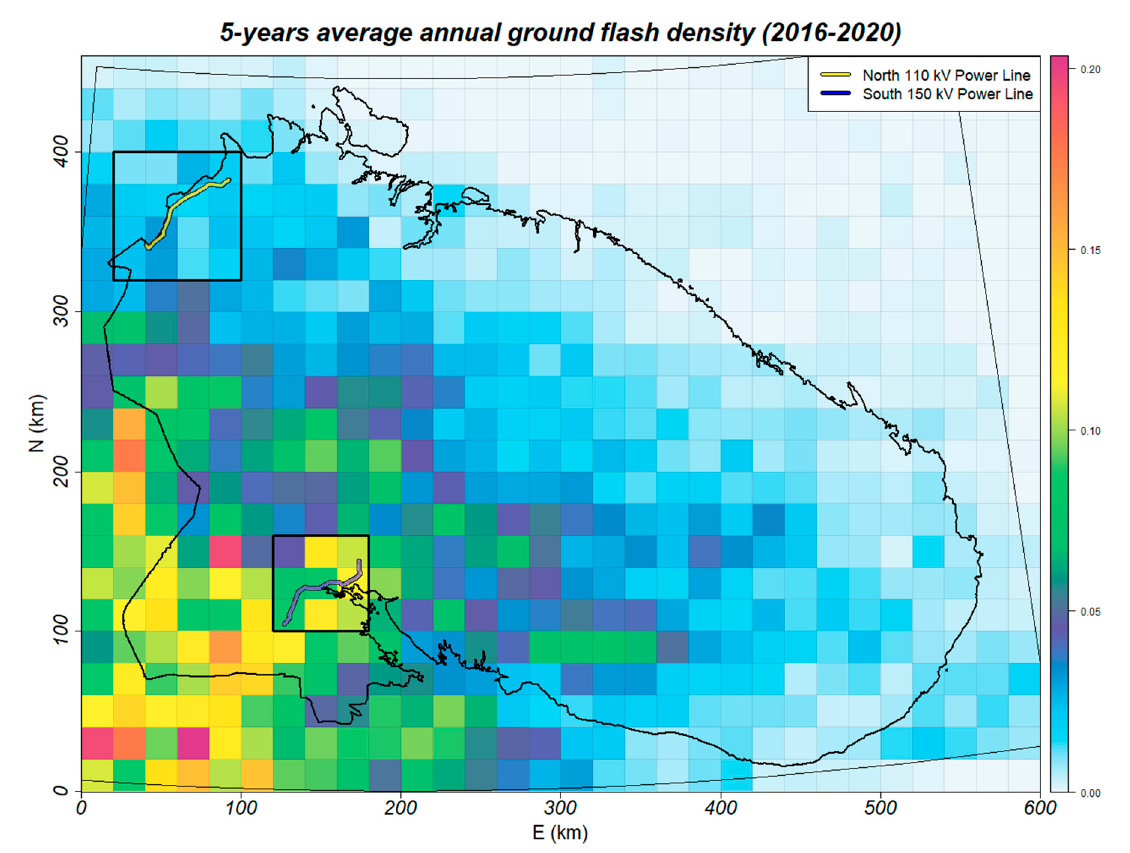
Figure 3. A map of the average annual ground flash density of the Murmansk region for 5 years (2016–2020). The map shows the “North” OHTL (from above, 110 kV, 269 towers, 75 km length) and the “South” OHTL (from below, 150 kV, 300 towers, 74.6 km length).